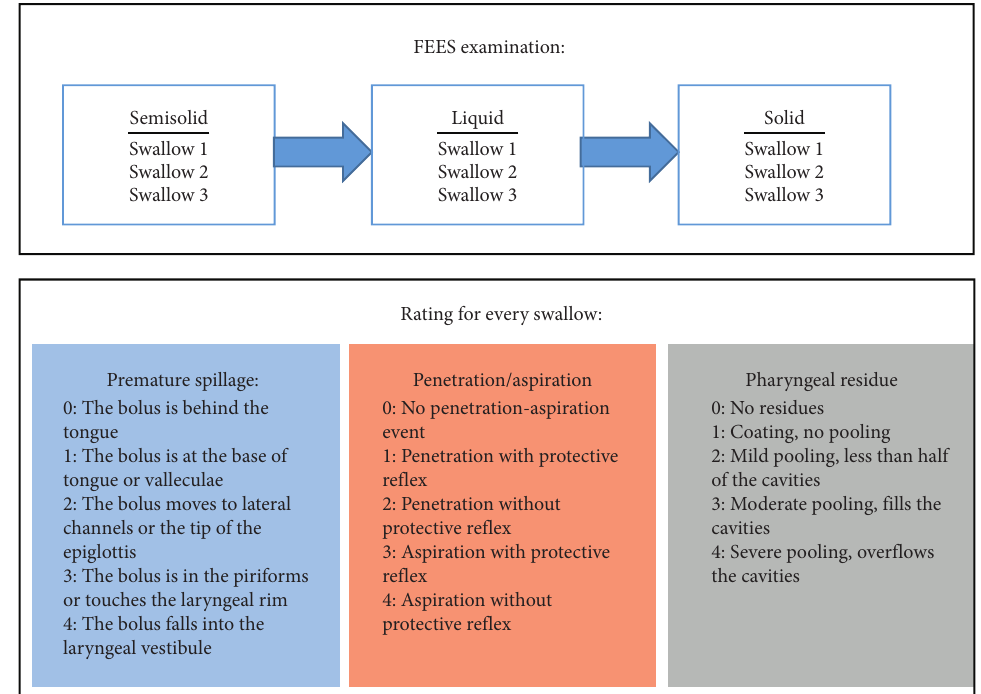
Figure 1: Illustration of the FEES examination protocol and the rating of the FEES